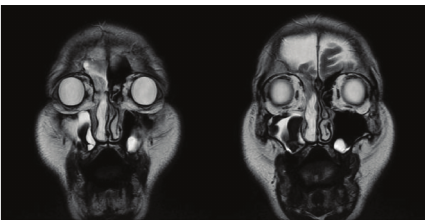
Figure 3: MRI showed that the tumor had high signal intensity surrounded by an isointense area on the T2-weighted image. No connection was observed with the meninges or cerebral